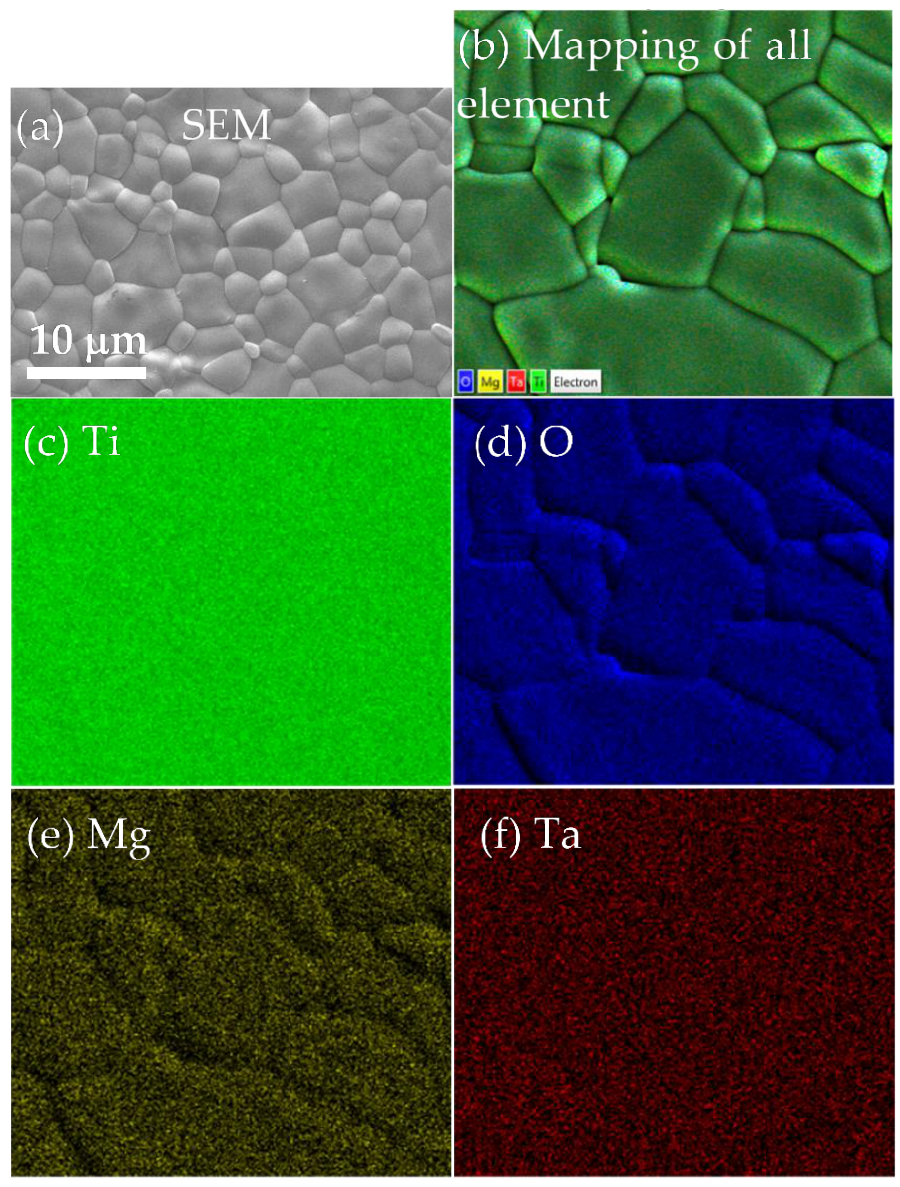
Figure 2. SEM image of an as-MTTO ceramic sample ( a ) and FE-SEM mapping images of all elements ( b ), Ti ( c) , O ( d) , Mg ( e ), and Ta ( f ).